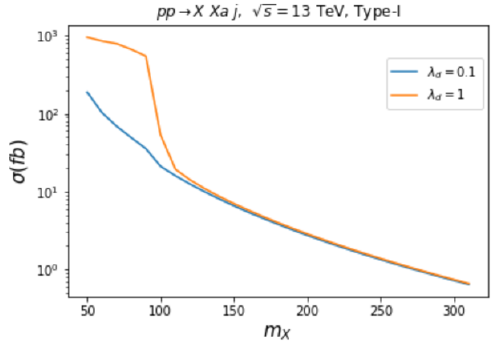
Figure 13 . Cross sections for the process pp ! j (cid:31)(cid:31) a as a function of DM mass for tan (cid:12) = 2 and m A = 200 GeV. The mass parameter m (cid:31) m (cid:31) (cid:0) m (cid:31) = 1 GeV. a